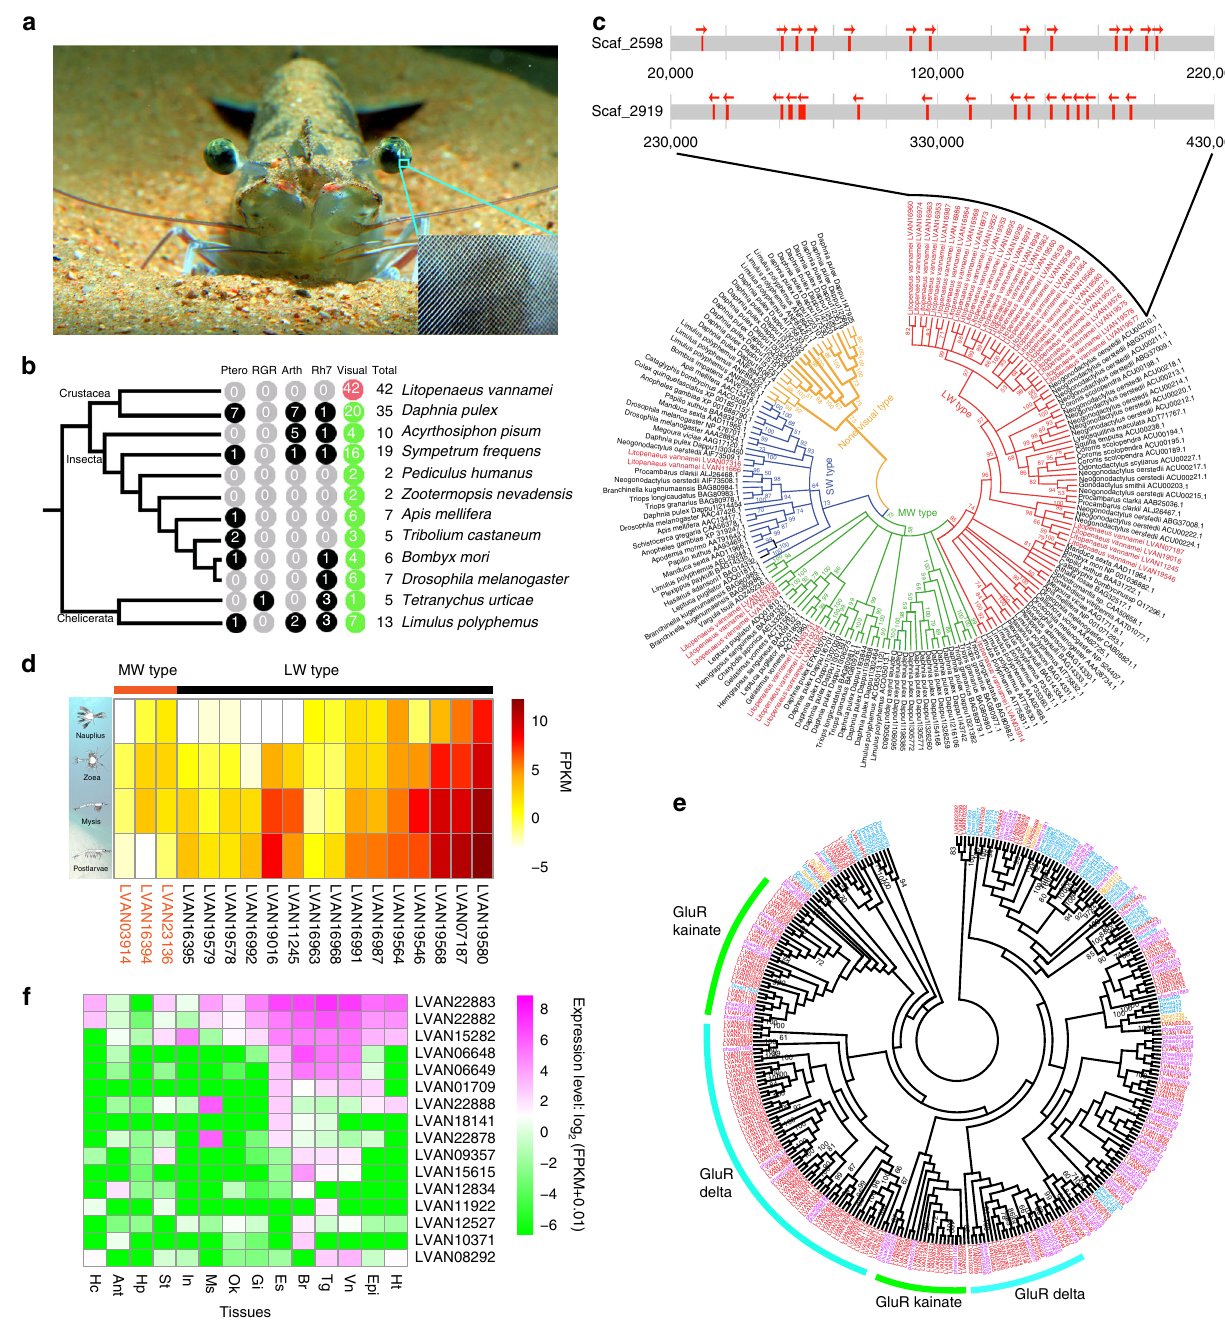
Fig. 3 Opsin and iGluR gene family in the shrimp genome. a Picture of the L. vannamei eyes and ommatidia. b Opsin genes of L. vannamei in comparison with those in the genomes of various arthropods. The number of visual and nonvisual type opsin genes, including pteropsin (Ptero), RGR-like (RGR), arthropsin (Arth), Rh7-like (Rh7) were identi fi ed using sequence alignment with known opsins and GPCR-domain searches (Supplementary Fig. 18). c Phylogenetic tree of the opsin gene family in arthropods. Six clades of opsins in the L. vannamei genome were observed (red). The genes in largest clade are speci fi cally expanded opsins in the L. vannamei genome, which are also tandemly duplicated. The arrow indicates the transcriptional orientation. d Expression of opsin genes (FPKM>1) during different larval stages of L. vannamei . e Expansion of ionotropic glutamate receptor (iGluR) genes in L. vannamei . f Expression of iGluR genes in different tissues: hemocyte (Hc), antennal gland (Ant), hepatopancreas (Hp), stomach (St), intestine (In), muscle (Ms), lymphoid organ (Ok), gill (Gi), eyestalk (Es), brain (Br), thoracic ganglion (Tg), ventral ganglion (Vn), epidermis (Epi), heart (Ht). GPCR G protein-coupled receptor